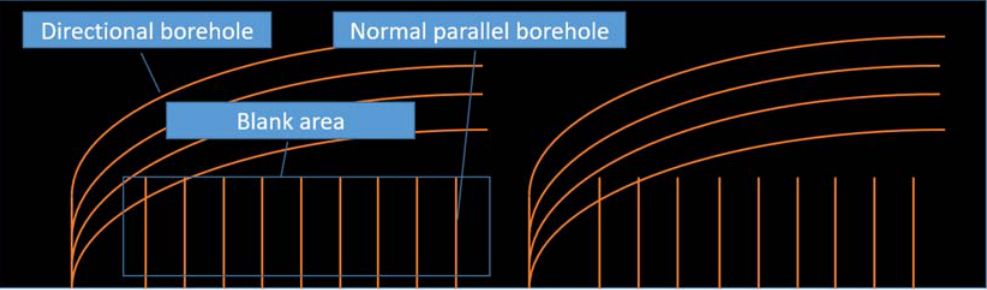
quantify the length between the two adjacent boreholes for both directional boreholes and normal parallel boreholes. Six simulation scenarios were carried out, as shown in Table 3.